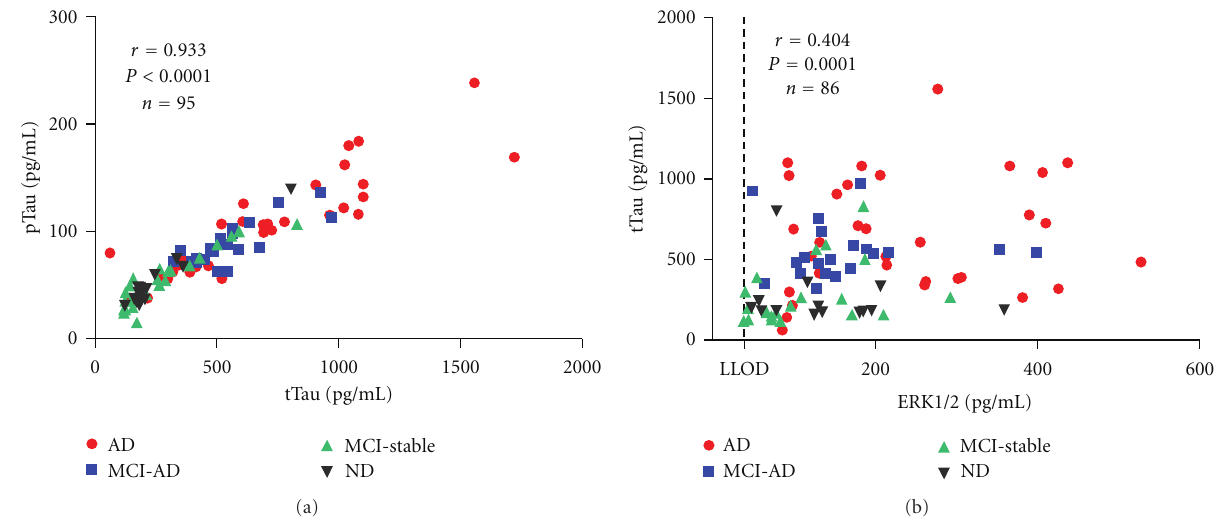
Figure 2: Correlations between tTau and pTau and between tTau and ERK1/2. In the whole sample, the CSF concentrations of tTau were significantly correlated with (a) pTau and (b) ERK1/2. ERK1/2 measurements below the LLOD of the respective assay plate ( n = 9) were excluded from the Spearman correlation test. Table 2: Analysis for correlations between ERK1/2 and classical biomarkers ∗ .